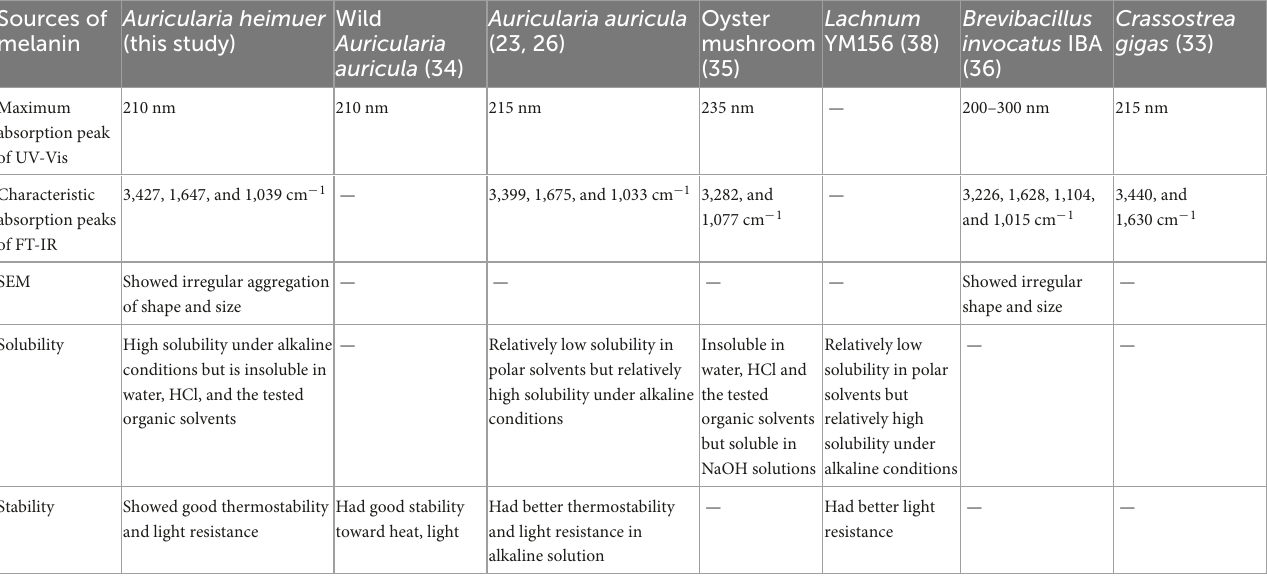
TABLE 4 The physicochemical properties of different sources of melanin. Sources of